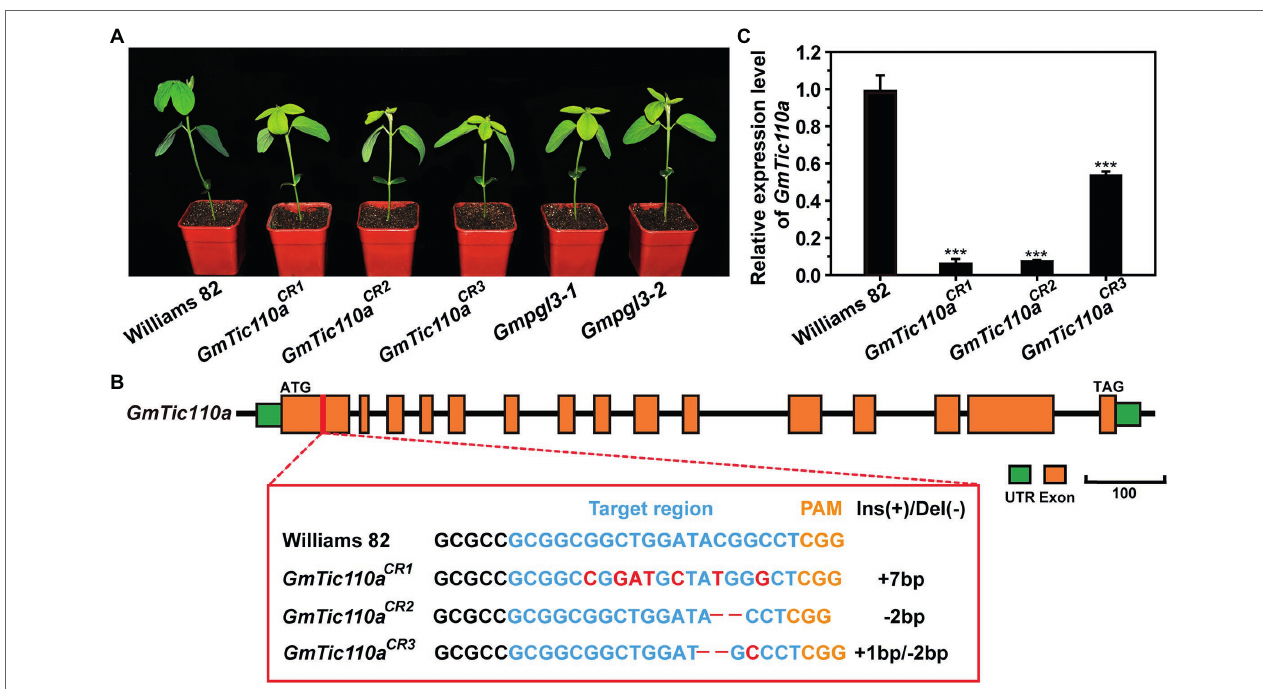
FIGURE 4 | (A) Phenotypes of Williams 82, the Gmpgl3 mutant, and CRISPR/Cas9-edited plants ( GmTic110a CR1 , GmTic110a CR , 2 and GmTic110a CR3 ). Scale bar = 1 cm. (B) sgRNA target sequences of Williams 82, GmTic110a CR1 , GmTic110a CR2 , and GmTic110a CR3 . The sgRNA target sequence is shown in blue letters, and the protospacer-adjacent motif (PAM) site is shown in yellow letters. The red letters indicate a single-base substitution. – indicates a deletion of the corresponding nucleotide. (C) Relative expression of the GmTic110a gene in unifoliate leaves of Williams 82, the Gmpgl3 mutant, and CRISPR/Cas9-edited plants. The asterisks indicate statistically significant differences, as determined by Student’s t -test (***, p < 0.001), and the error bars represent the standard